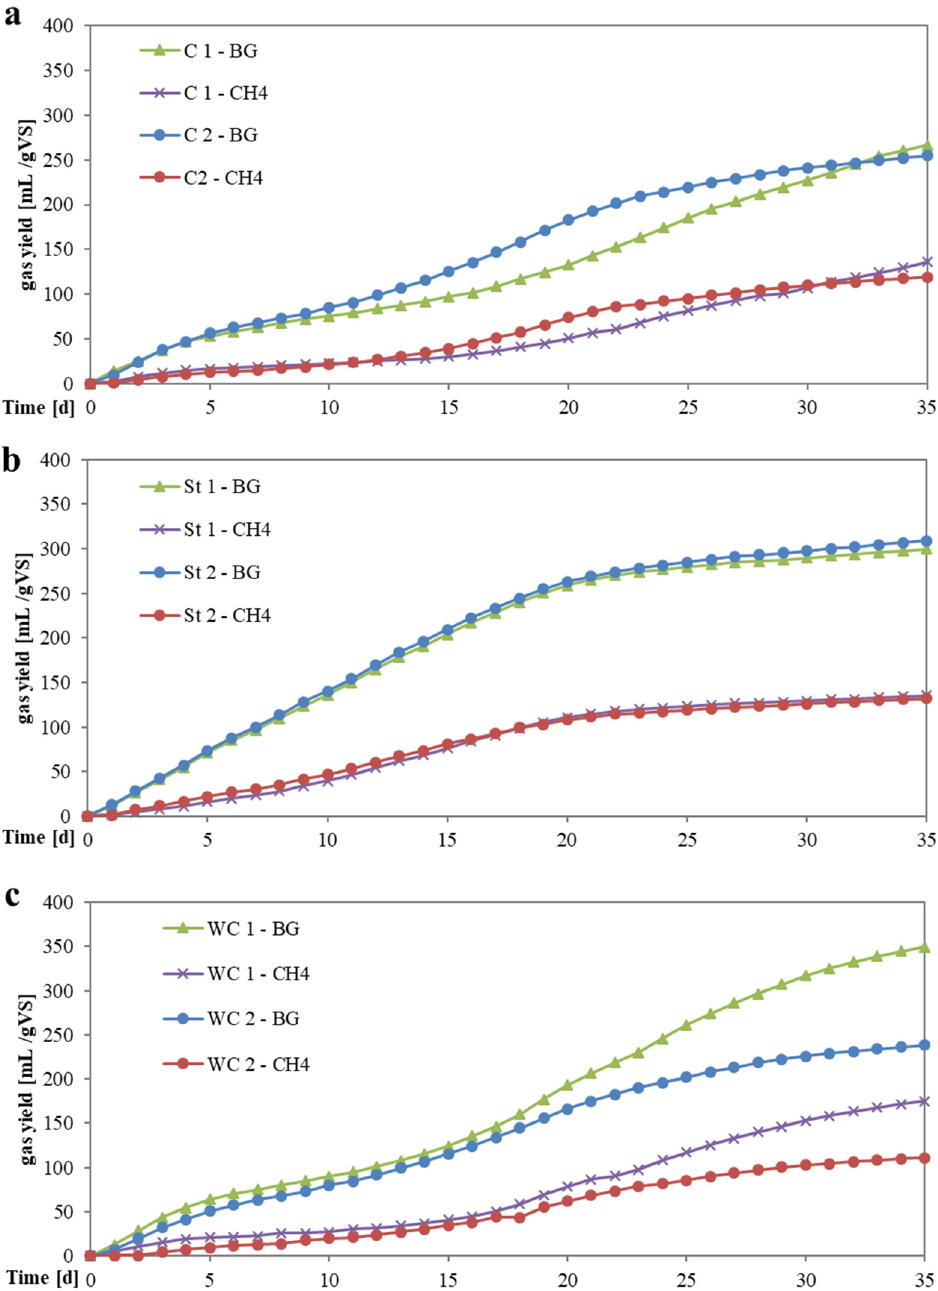
Figure 5. ( a – c ) Specific yield of biogas (BG) and methane (CH4) of chicken manure in dry batch anaerobic digestion. C, control variant ( a ); St, straw variant ( b ); WC, wood chip variant ( c